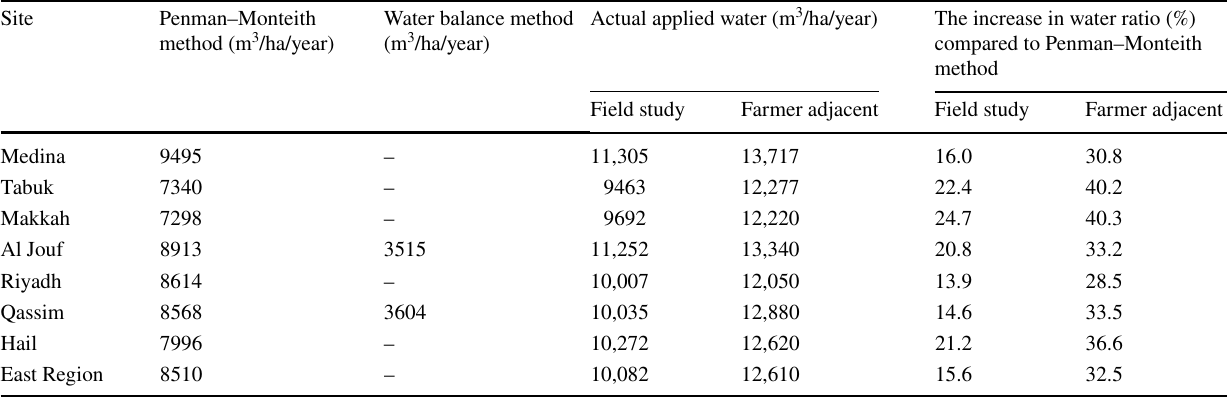
Table 4 Comparison between Penman–Monteith calculations and actual amount of applied water in the different sites, and increase in water ratio (%) compared to Penman–Monteith